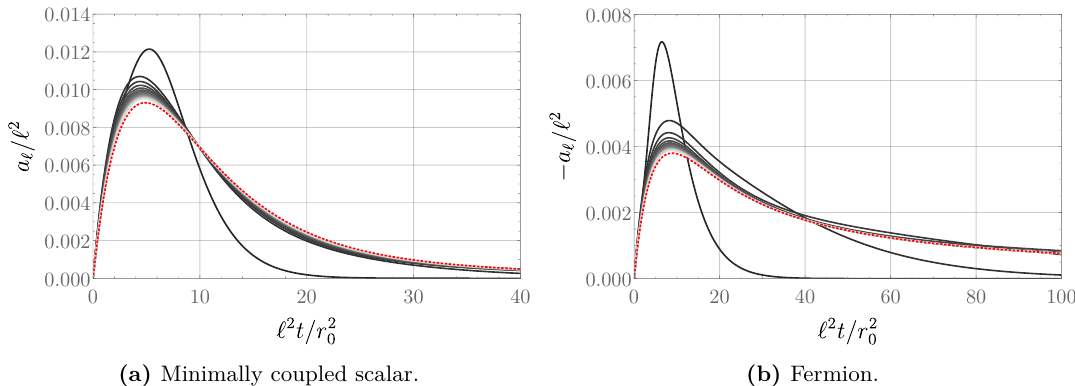
Figure 1. The function a ‘ ( t ) for even ‘ for the minimally coupled scalar (left) and the Dirac fermion (right); from dark to light gray, the curves correspond to ‘ = 2 to ‘ = 40 . The dashed red curve is the flat-space limit given by (3.35). The convergence of a ‘ ( t ) to the flat-space limit for the nonminimally coupled scalar is